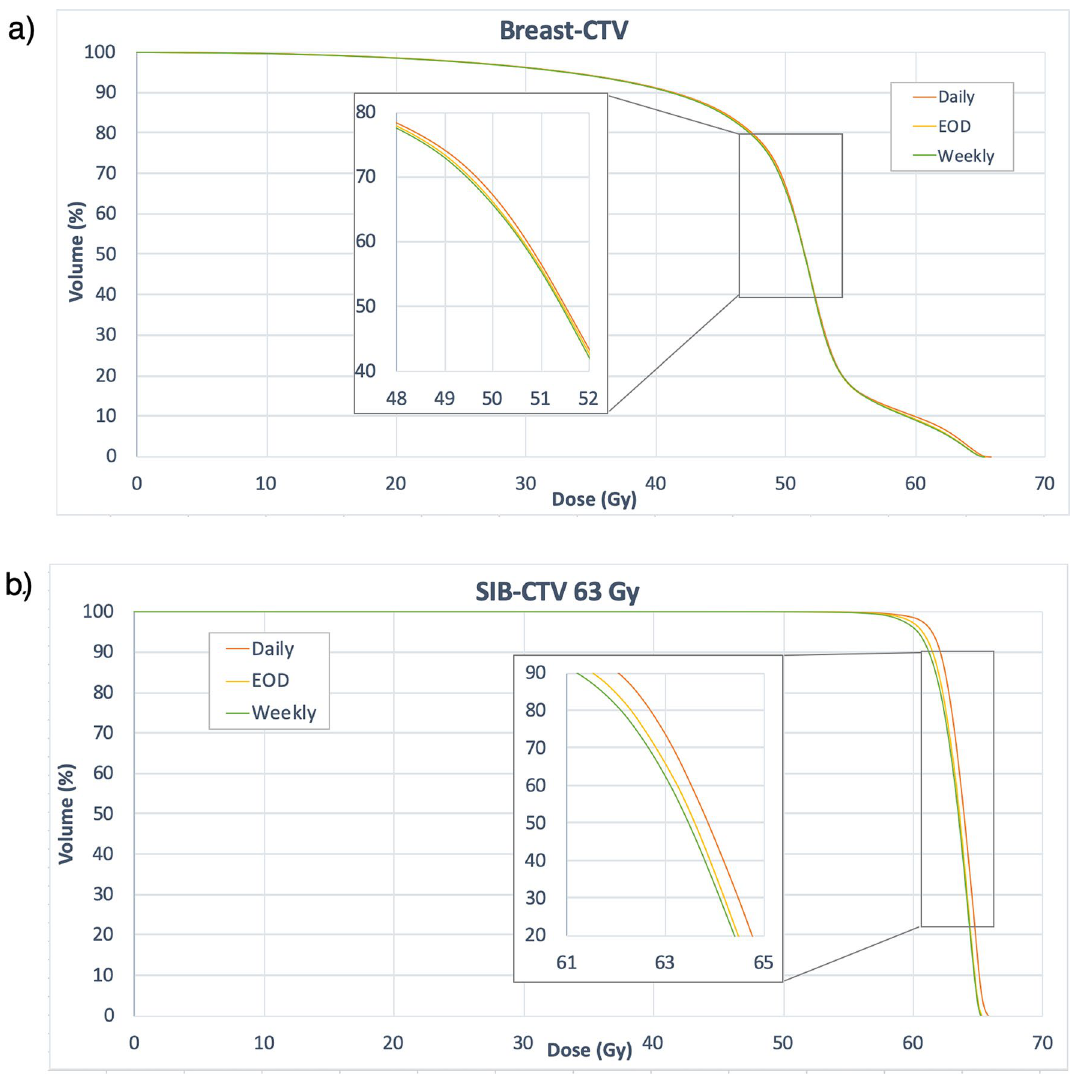
Figure 3. Dose volume histograms delineating the estimated delivered dose in the breast ( a ) and the SIB-CTV ( b ). Mean values of 28 patients with a prescribed dose to the Breast-PTV of 50.4 Gy and 63 Gy to the